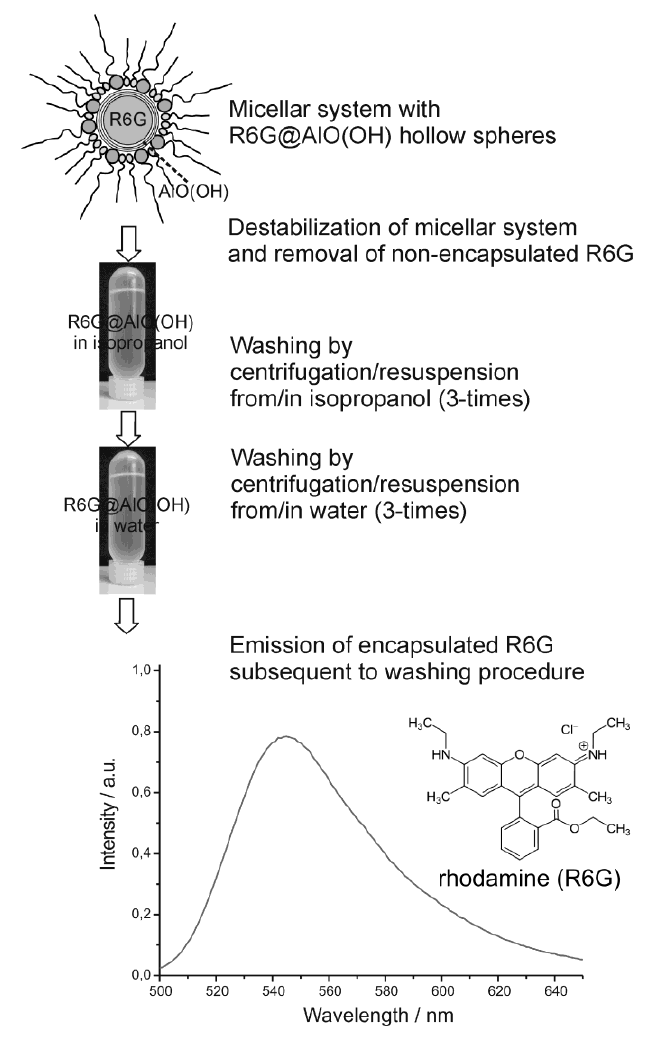
Figure 21. Proving the fluorescence of R6G@AlO(OH) subsequent to the